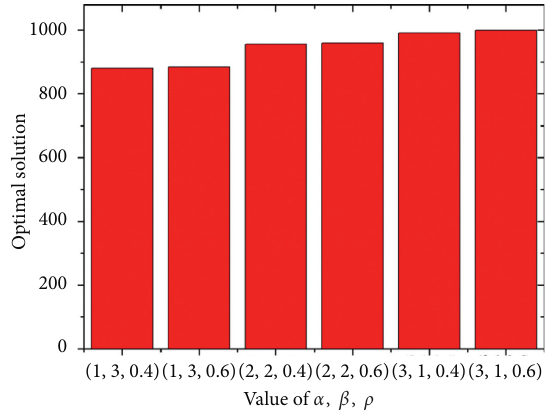
Figure 5: Effect of α , β , ρ on path